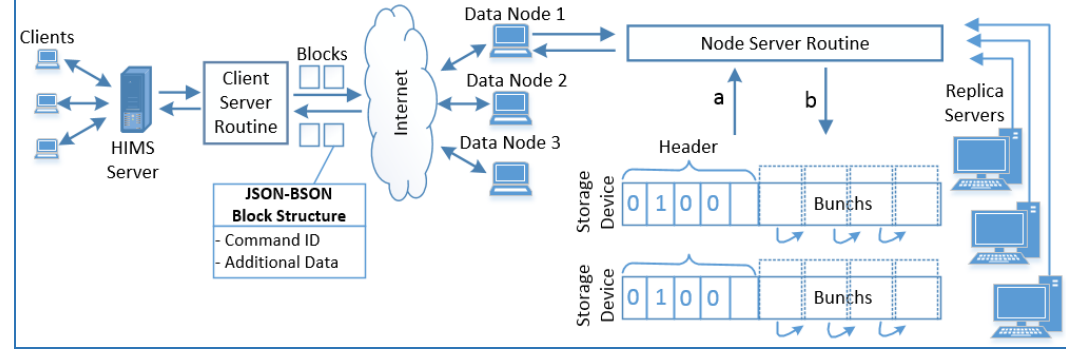
Figure 1. Windows service routines and JSON packages.